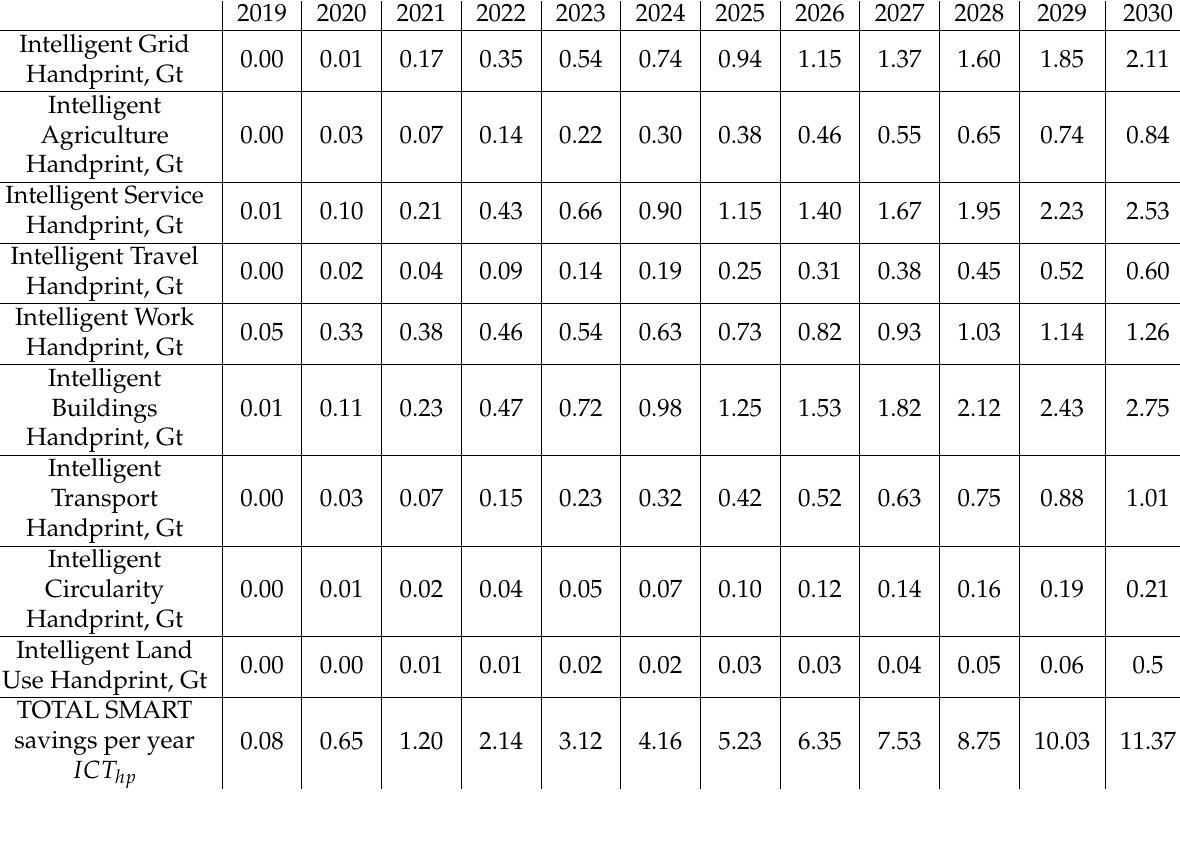
Table 5. Estimation of GHG supply (Gigatonnes) reductions enabled by ICT Solutions 2019-2030.